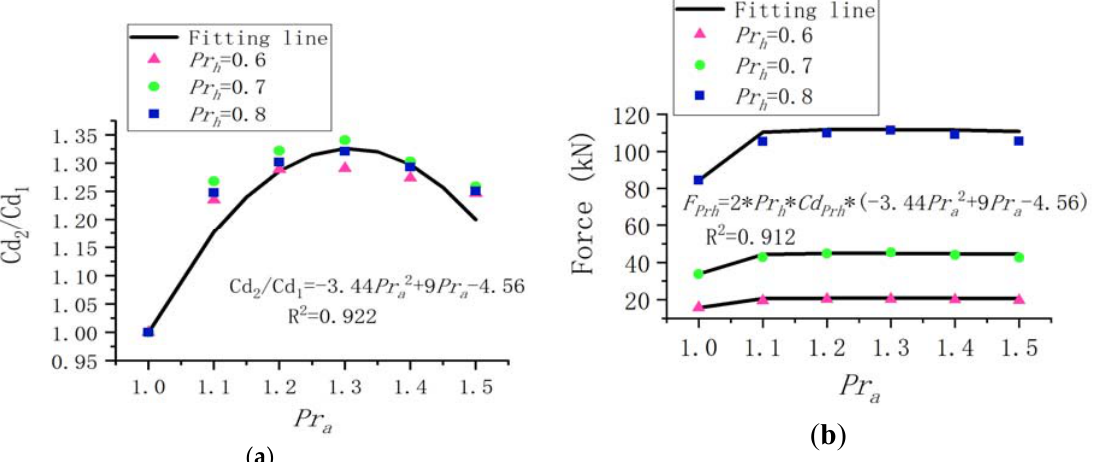
Figure 10. ( a ) Drag coefficient and ( b ) force at different area ratios (data sources: D1–D18).